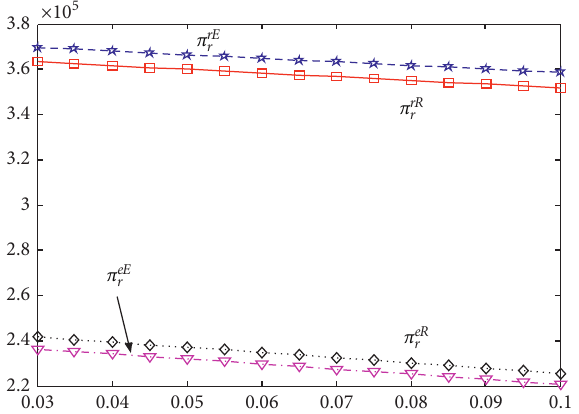
Figure 8: Optimal system profit over ρ